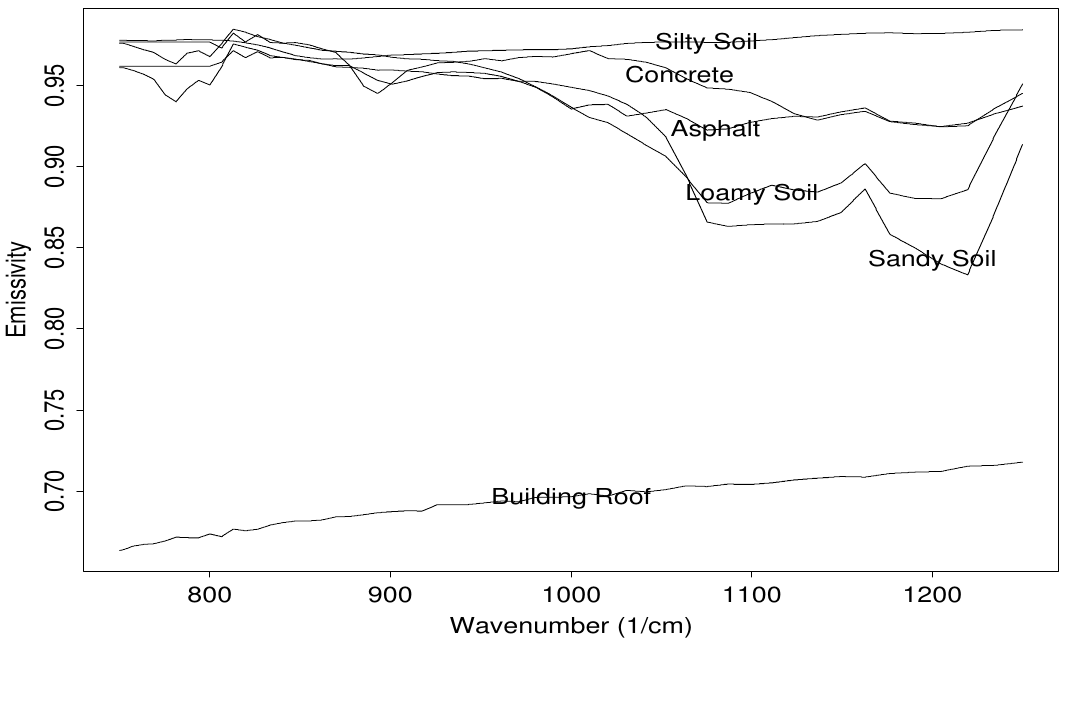
Figure 1 . Emissivities of materials used in the